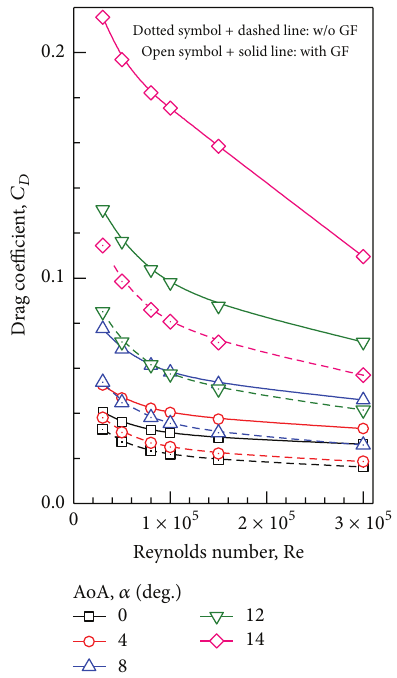
Figure 6: Variation of 𝐶 𝐷 with Reynolds number for the airfoil without and with GF.